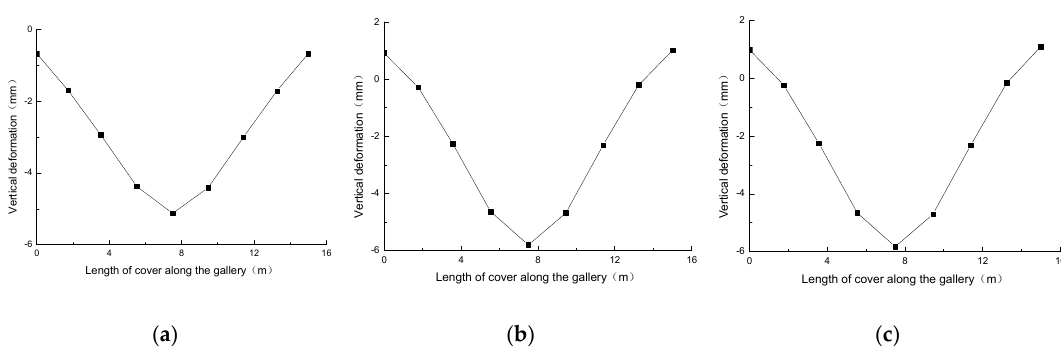
Figure 11. Deformation curve of the right subway line. ( a ) Section 1; ( b ) Section 2; ( c ) Section 3.